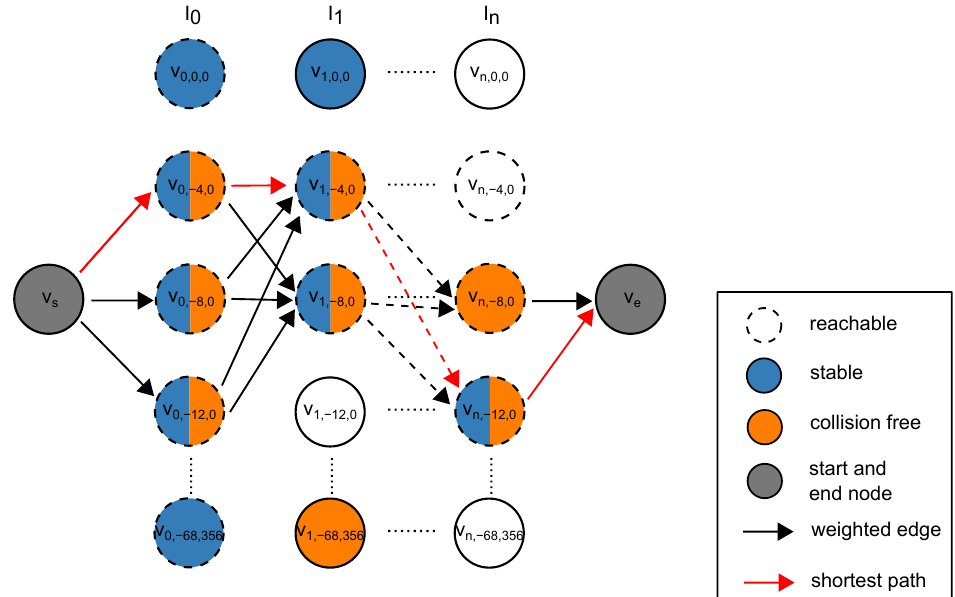
Figure 9. Resulting tool orientation from the optimisation for each point of the NC